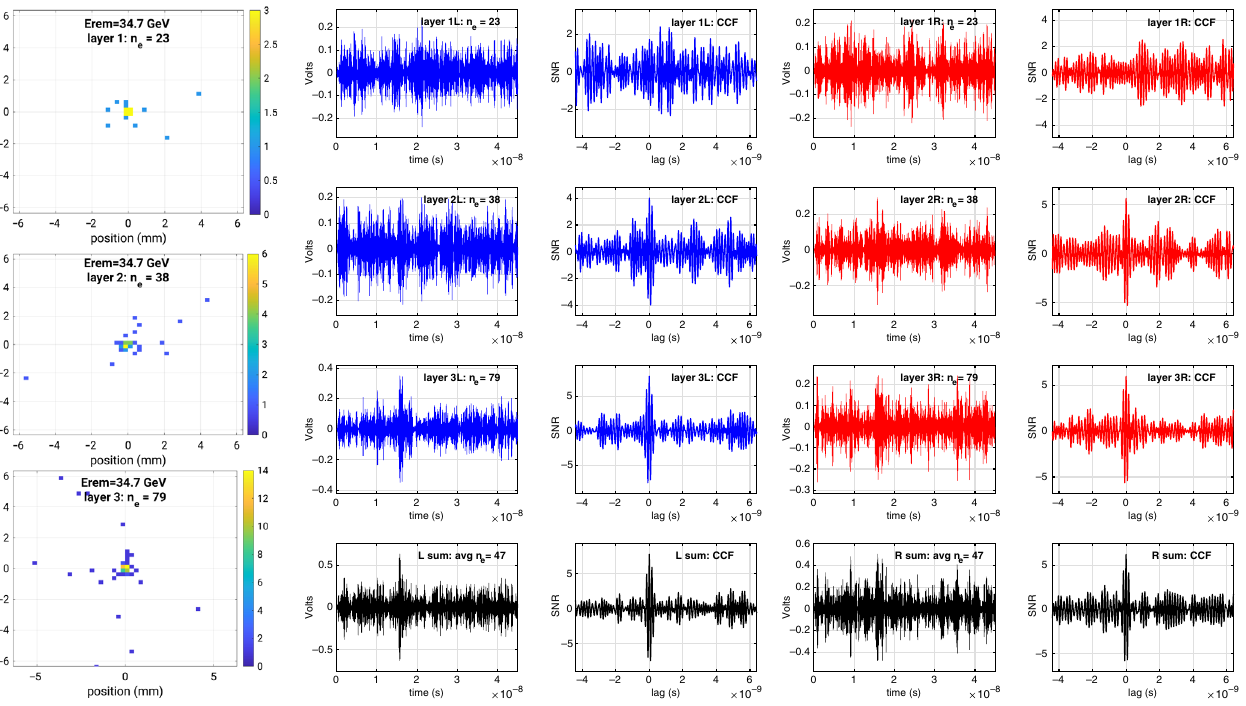
FIG. 25. Left column: distribution of throughgoing charged particles for a single realization of a photon shower transiting three layers of our timing plane. The remaining four columns show, from left to right, (1) the microwave signal at the left end of the ACE waveguide, (2) its cross-correlation with the template response function for the signal; (3) and (4), similar waveforms and CCFs for the microwave signal at the right end of the waveguides. From top to bottom, we show the signals and CCFs for each of the three layers, followed by the coherent sum in the bottom